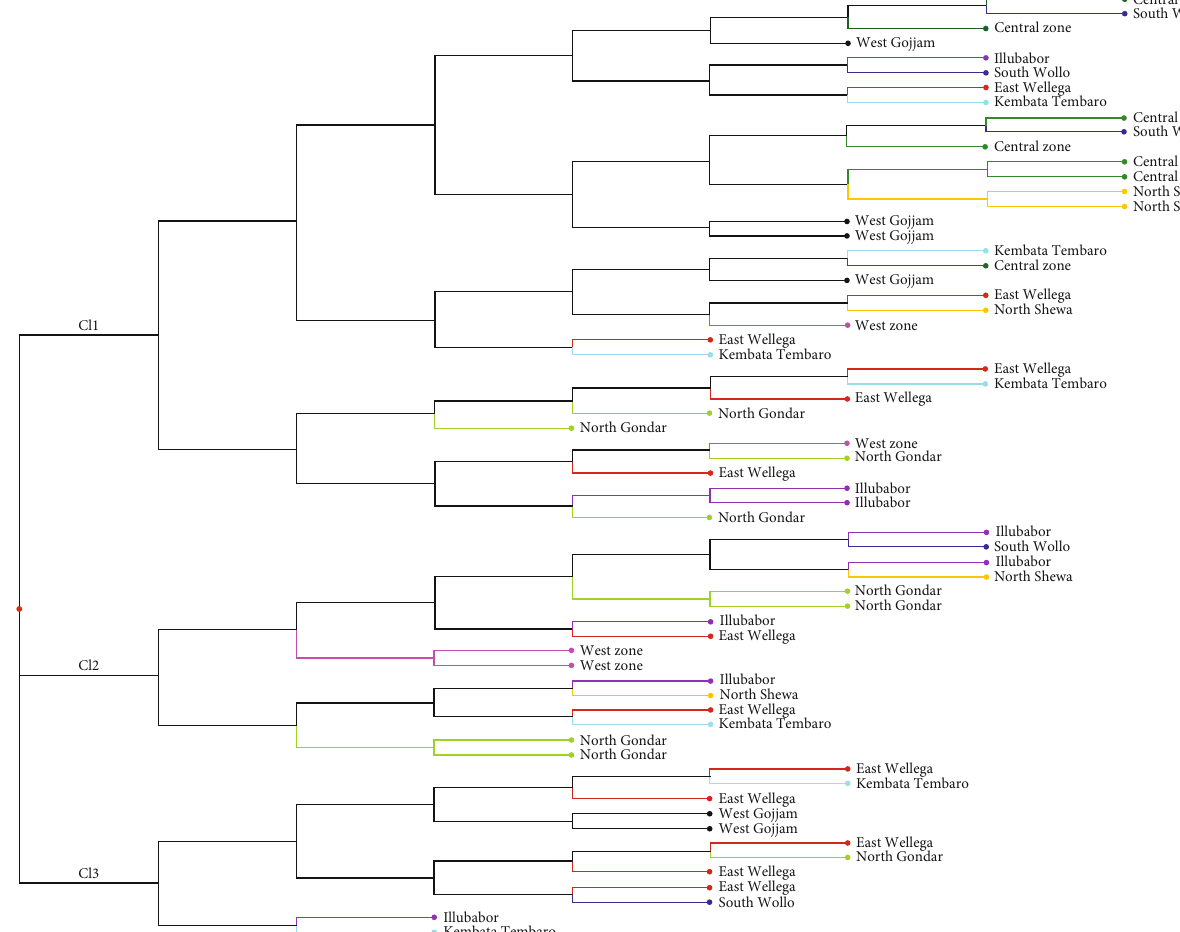
Figure 2: Unweighted neighbor-joining (NJ) dendrogram showing a genetic relationship of 64 tef accessions using 10 SSR